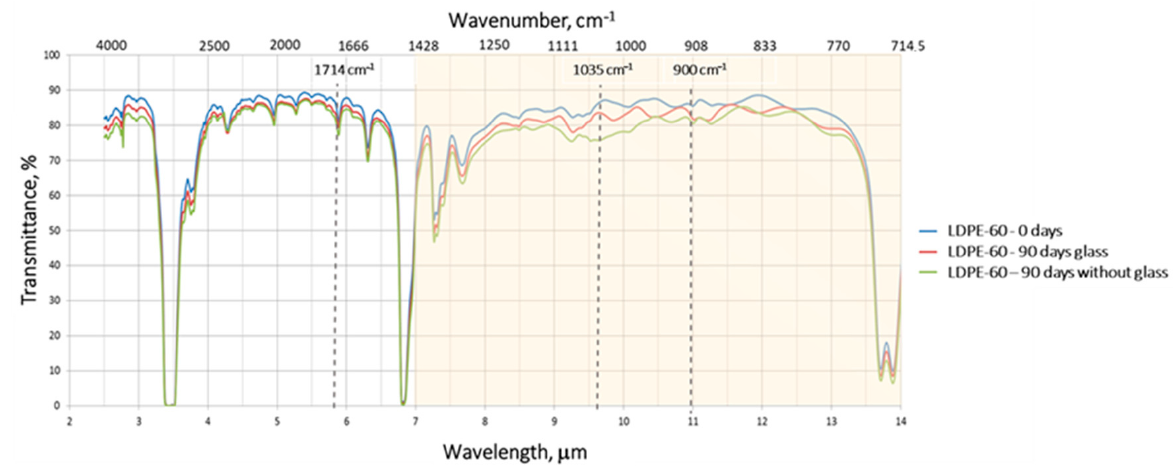
Figure 9. LDPE-60 FT-IR spectra in transmission mode.